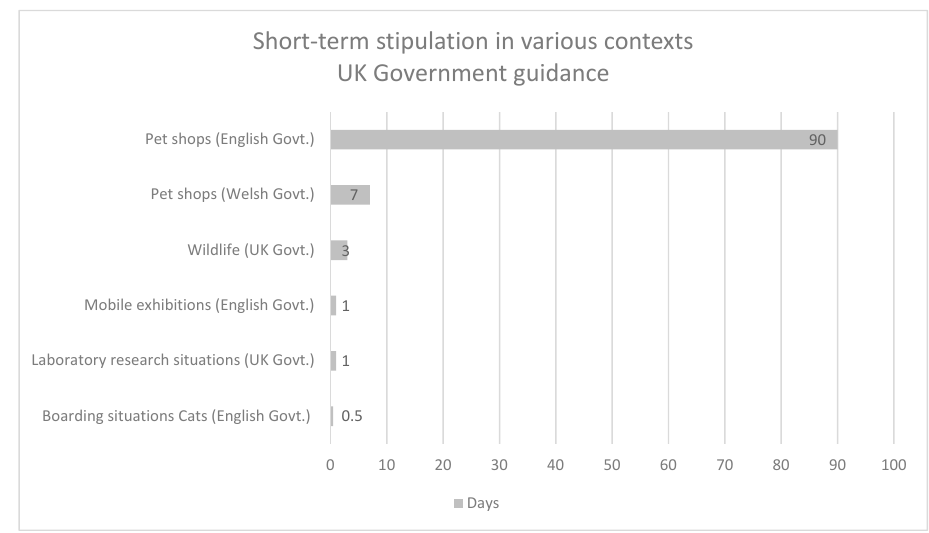
Figure 2. Comparative context for information contained in Table 1. (References [18–23]). Animals 2023 , 13 , 732